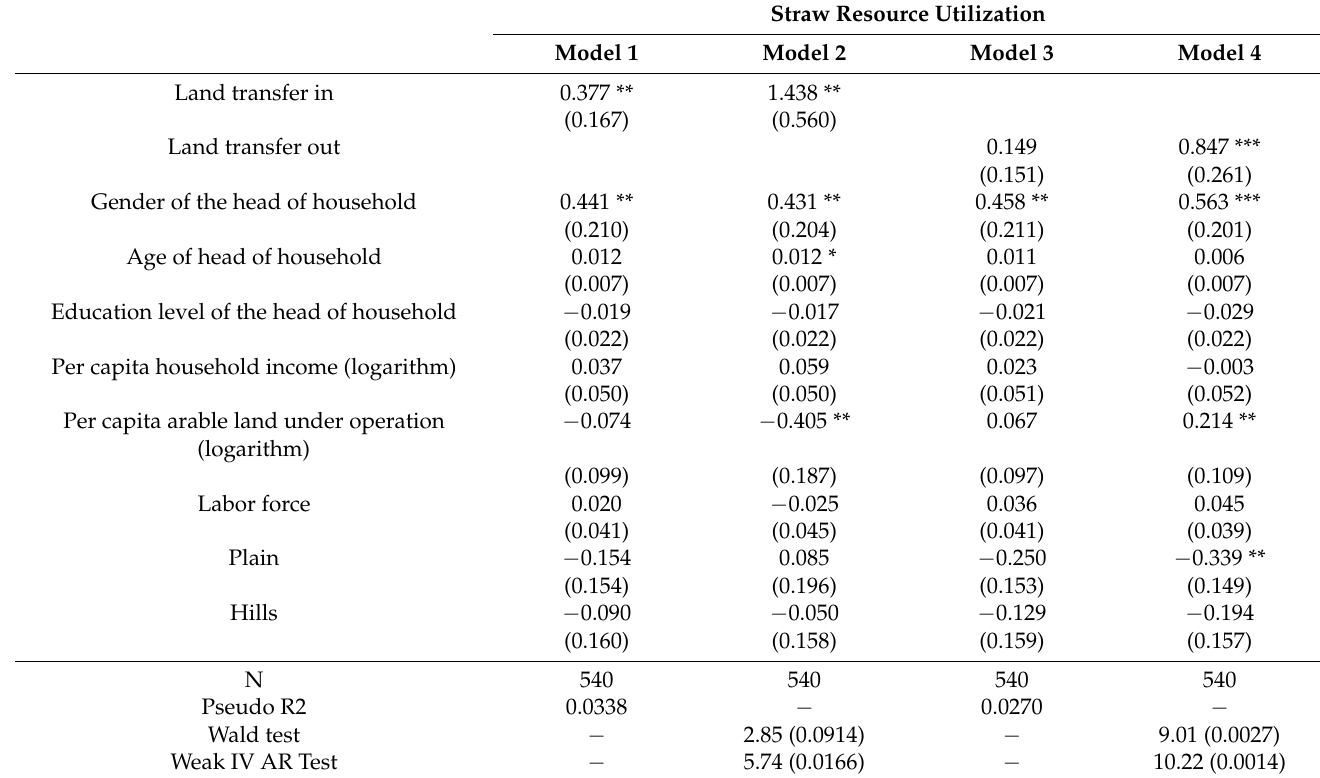
Table 3. Regression results of land transfer on straw resource utilization.